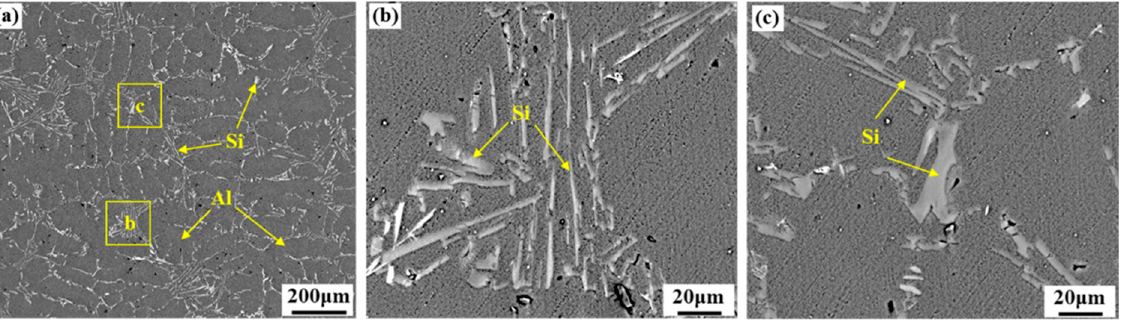
Figure 1. ( a ) Original microstructures of the A356 insert; ( b ) microstructures zoom in area b in ( a ); ( c ) microstructures zoom in area c in ( a ).